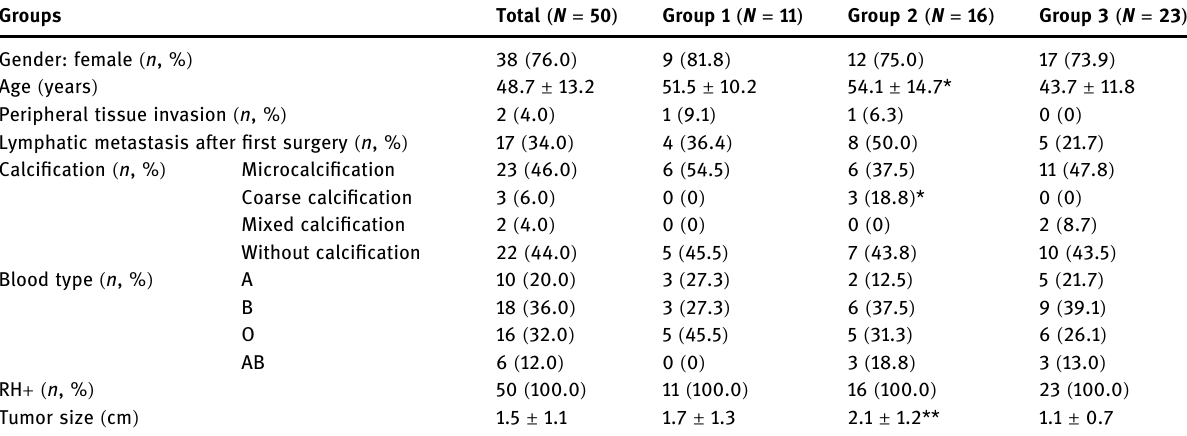
Table 1: Epidemiological and clinical characteristics of the patients Groups